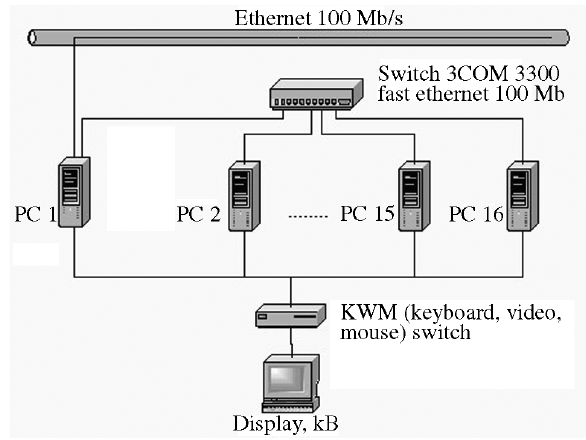
Figure 6 - Speedup based in computation time + I/O for 3226 genes as complete feature space and 2 genes as small feature